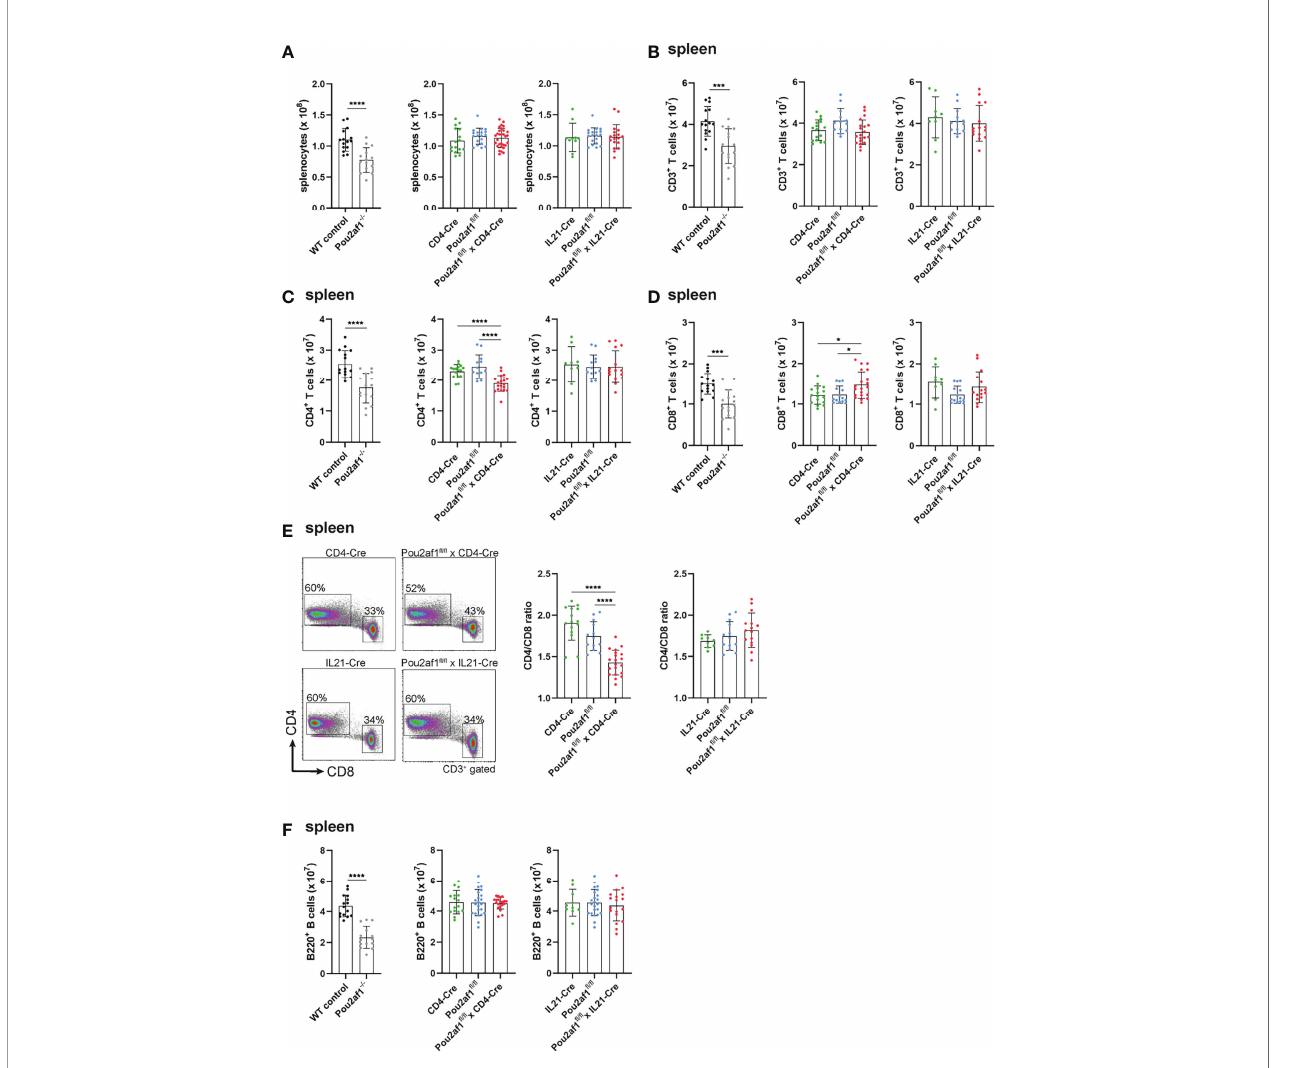
FIGURE 2 | BOB.1/OBF.1 de fi ciency in CD4 + T cells alters the CD4/CD8 T cell ratio in the periphery. (A) Statistical representation of the number of splenocytes after lysis of erythrocytes. (B – D) Statistical representation of CD3 + (B) , CD4 + (C) and CD8 + (D) T cell numbers in the spleen assessed by fl ow cytometry. Each point represents data from a single mouse. Data in the graphs are shown as means ± SD (n = at least 13 mice per group). (E) Representative fl ow cytometry plots of CD4 + and CD8 + T cells and statstical analysis of the CD4/CD8 T cell ratio in the spleen. Gating strategy is shown in Figure S8. (F) Statistics of fl ow cytometric analyses showing B220 + B cell numbers in the spleen. Data are merged from at least three independent experiments. *p < 0.05, ***p < 0.001, and ****p < 0.0001. P-values were determined using a two-tailed Student ’ s t test or Mann-Whitney-U